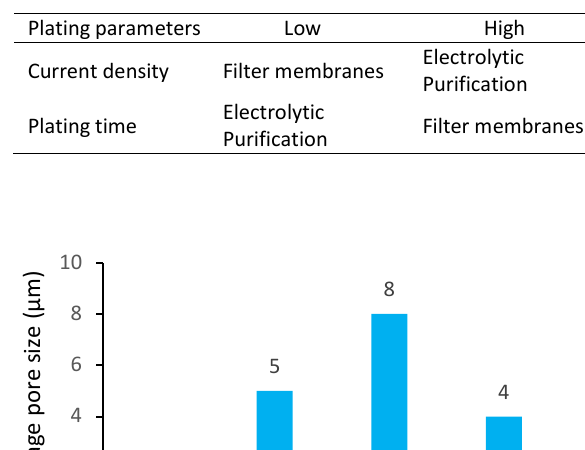
Application of nickel-chromium plating based on plating